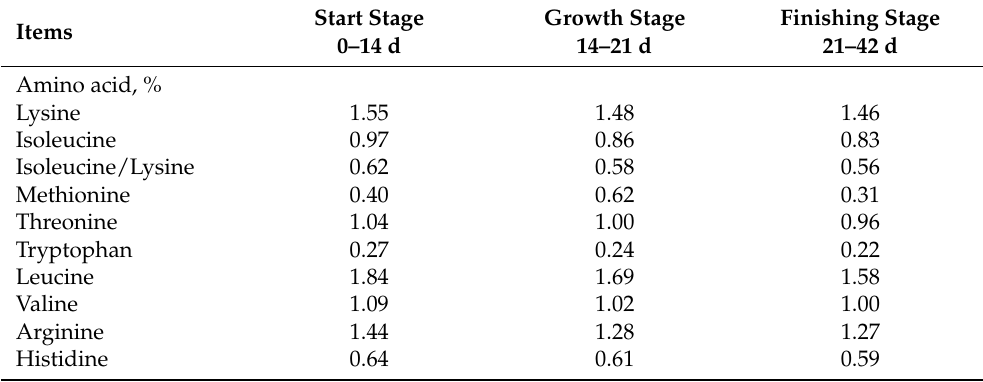
Table 2. The contents of amino acids in the basal